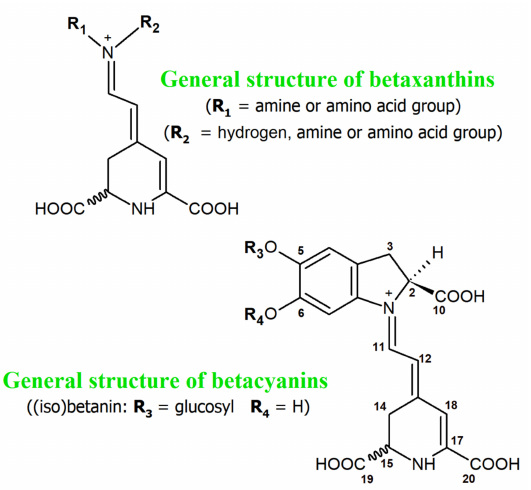
Figure 1. General chemical structures of betacyanins and betaxanthins.